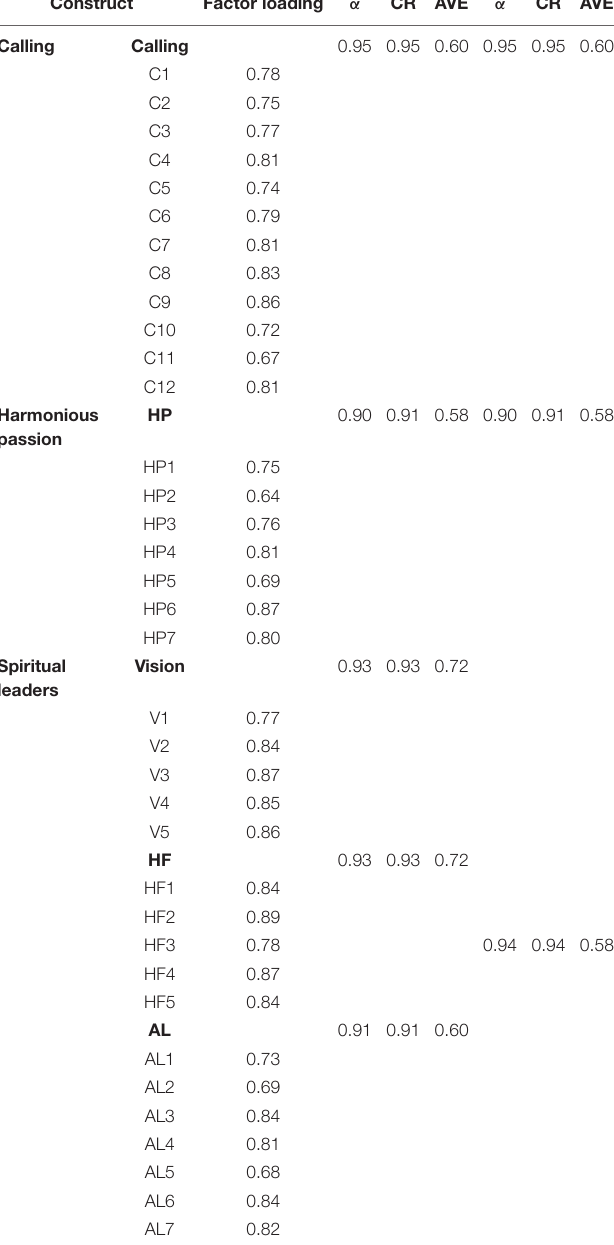
TABLE 3 | Result of measurement